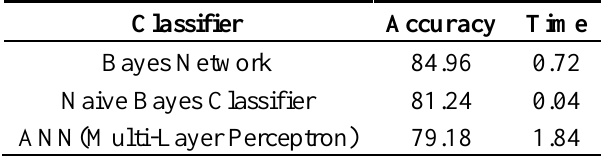
Table 5. Comparison of different classifiers in activity recognition of the DB of 120 min data using four essential features selected by SVM